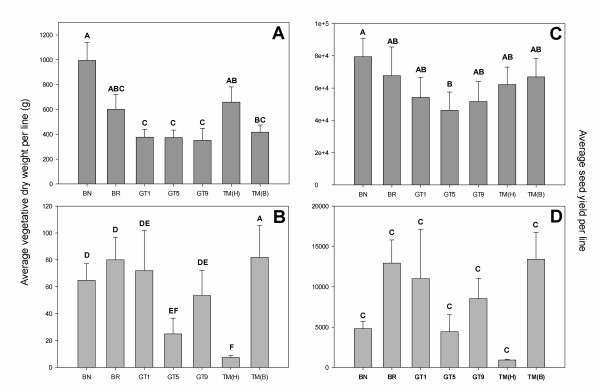
Transgenic Mitigation Study: Productivity. Average vegetative dry weight and seed yield (2e +4 = 20,000 seeds, 1e + 5 = 100,000 seeds, etc.) of non-transgenic Brassica napus (BN), Brassica rapa (BR), homozygous TM [TM(H)] and transgenic BC1/F2 hybrid populations [GT1, GT5, GT9 and TM(B)] being grown under non-competitive (A and C) and competitive field conditions (B and D). Bars with the same letter do not differ statistically (P < 0.0001). Error bars represent ± standard error of the means. Note that different Y-axis scales are used among figure panels.